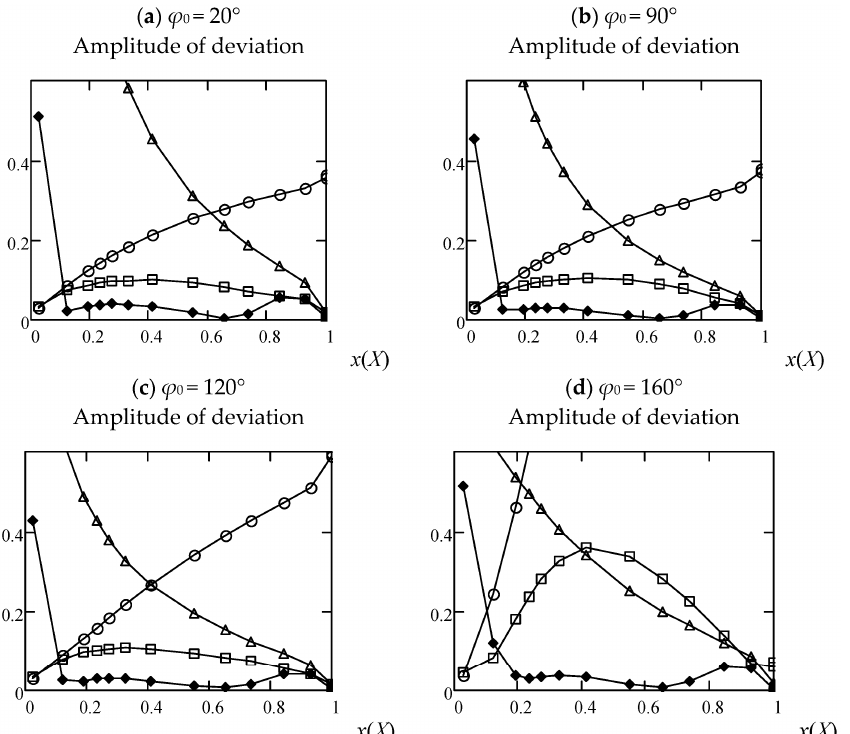
Figure 4. Quantitative characteristics of the deviation. Graphs that quantitatively describe the deviations of heuristic approximations from a rigorous solution for various angles of incidence ϕ 0 . The x ( X ) values are plotted horizontally. The amplitudes of the functions describing the mean deviation are plotted along the vertical axis. Circles—GDC (15), triangles—PODC (16), squares— Dh ( R , T , ϕ , ϕ 0 ) (17), and diamonds— Dh 0 ( R , T , ϕ , ϕ 0 )